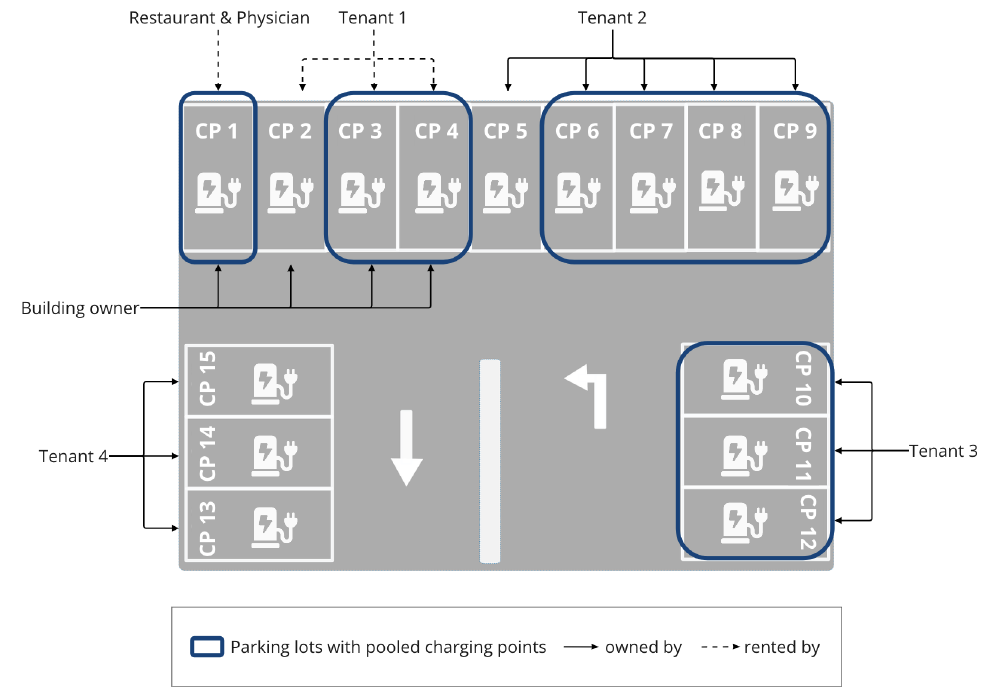
Figure 1. Example CP pooling scenario in an office building’s parking